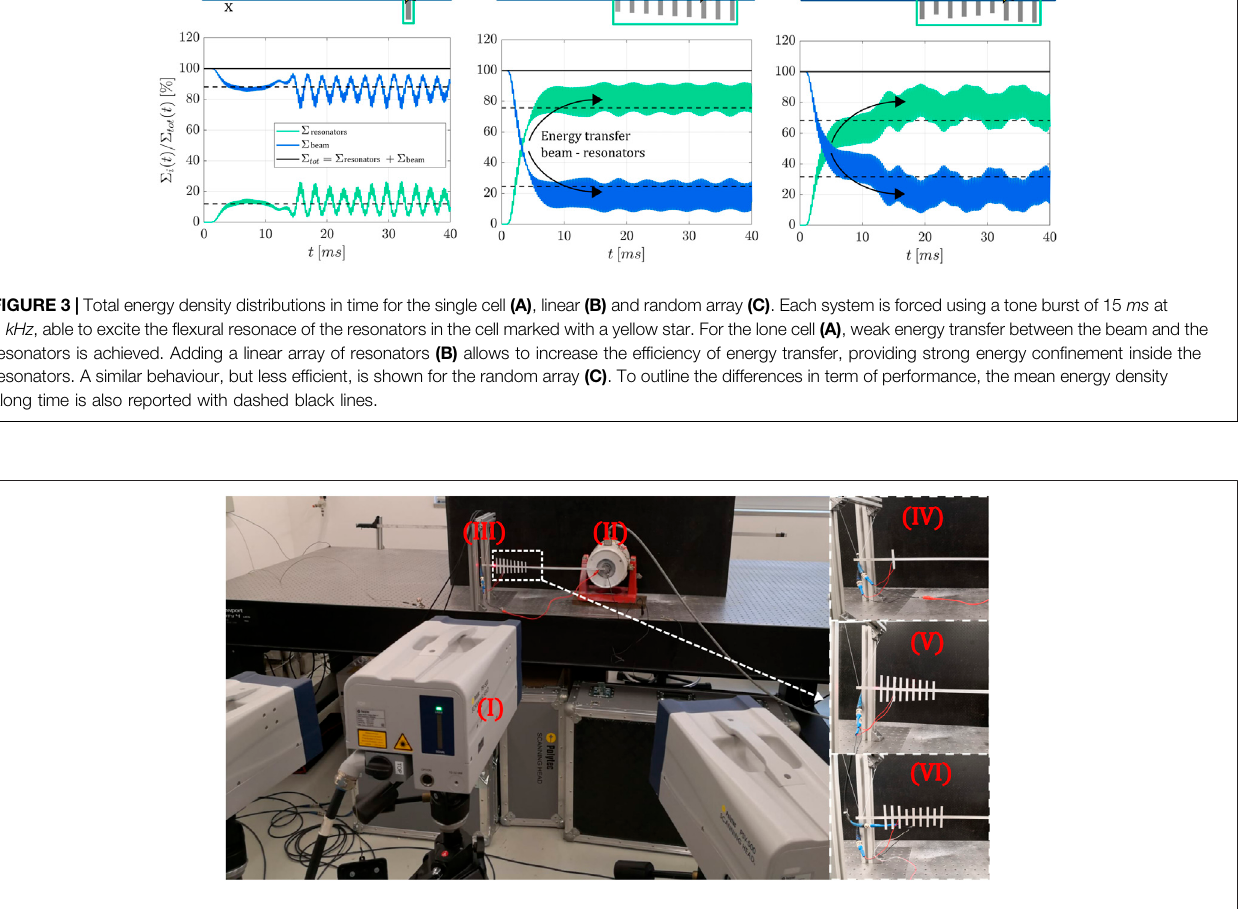
Frontiers in Materials |